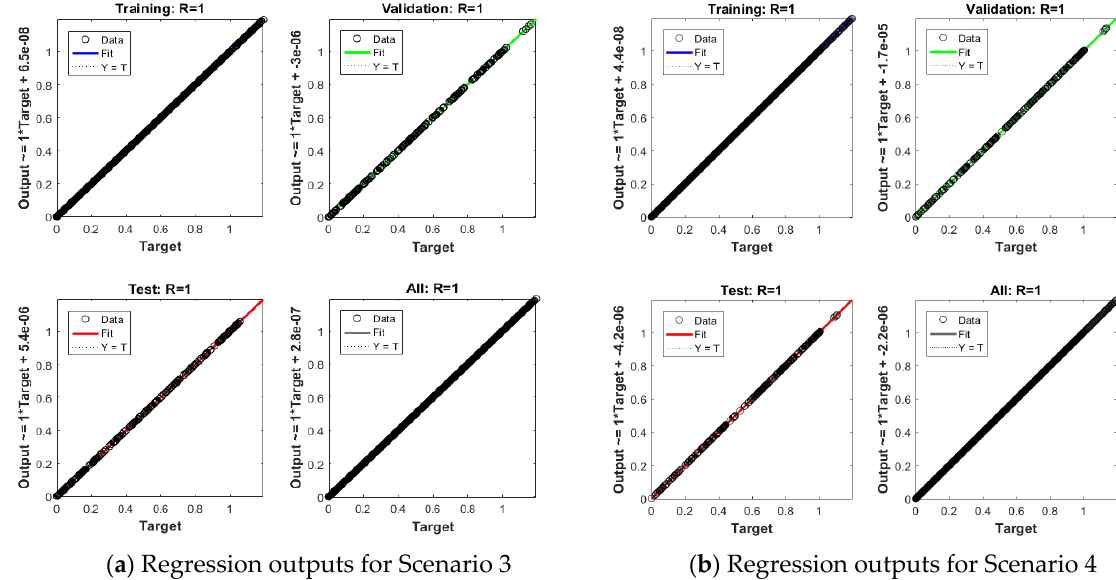
Figure 11 : Regression performance of the proposed TLMB-NN for solving HTM-BFN model with MHD of Scenarios 3 and 4.